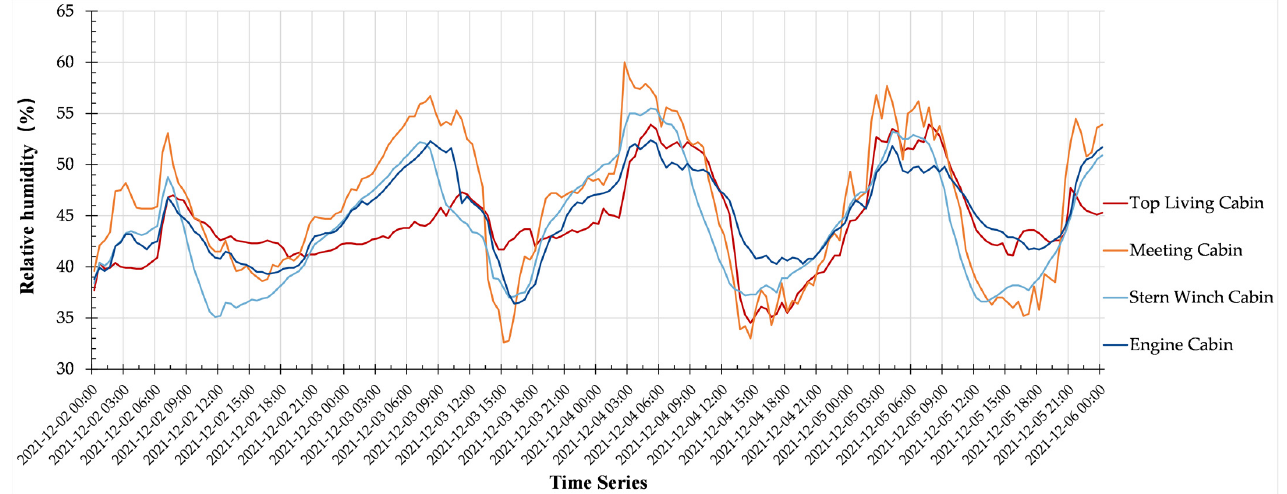
Figure 15. Relative humidity in the ship between 2 and 5 December 2021.